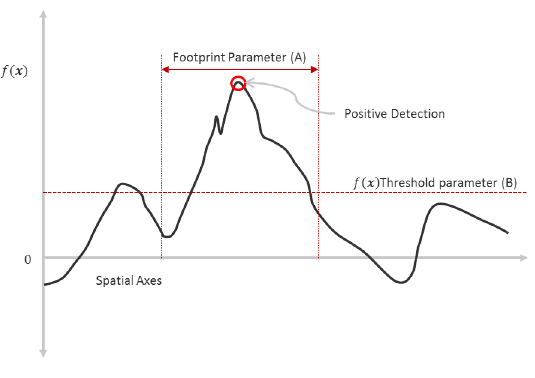
Figure 6: Local maximum detection are generated by manual selection of all object locations in the images. The precision-recall or users-producers accuracy, total accuracy and RMS localization error are computed for accuracy